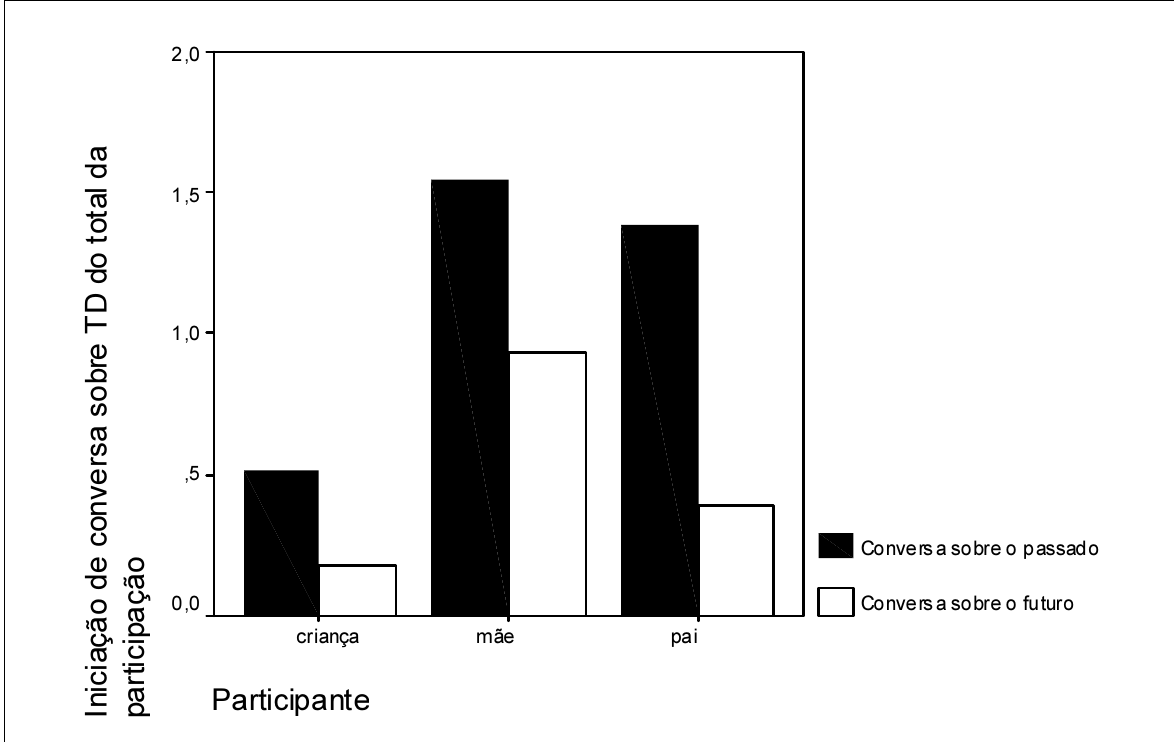
Figura 1. Iniciação de conversa sobre TD por